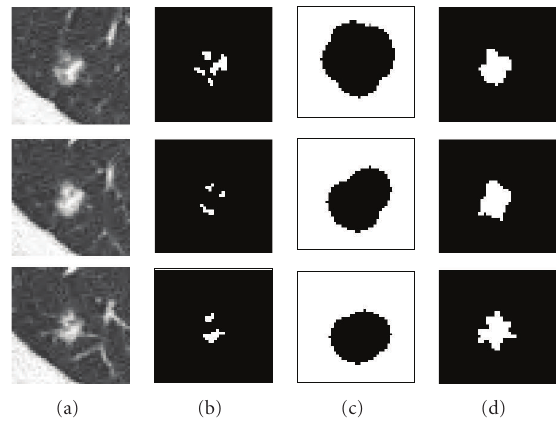
Figure 5: An example of the segmentation of a part-solid nodule based on the automatic calculation of the initialization (a) 3D nodule in three contiguous CT slices; (b) initial foreground based on high spherical concentration; (c) initial background; (d) segmentation results by the proposed graph cut based method.